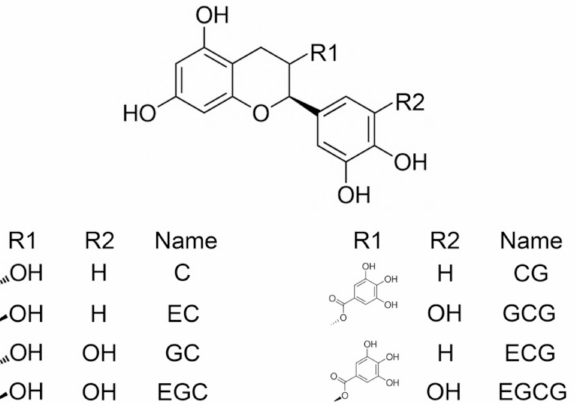
Figure 1. Structural formula of catechins. C, EC, GC, EGC, CG, GCG, ECG, and EGCG are short for (+)-catechin, ( − )-epicatechin, ( − )-gallocatechin, ( − )-epigallocatechin, ( − )-catechin gallate, ( − )- gallocatechin gallate, ( − )-epicatechin gallate, and ( − )-epigallocatechin gallate.